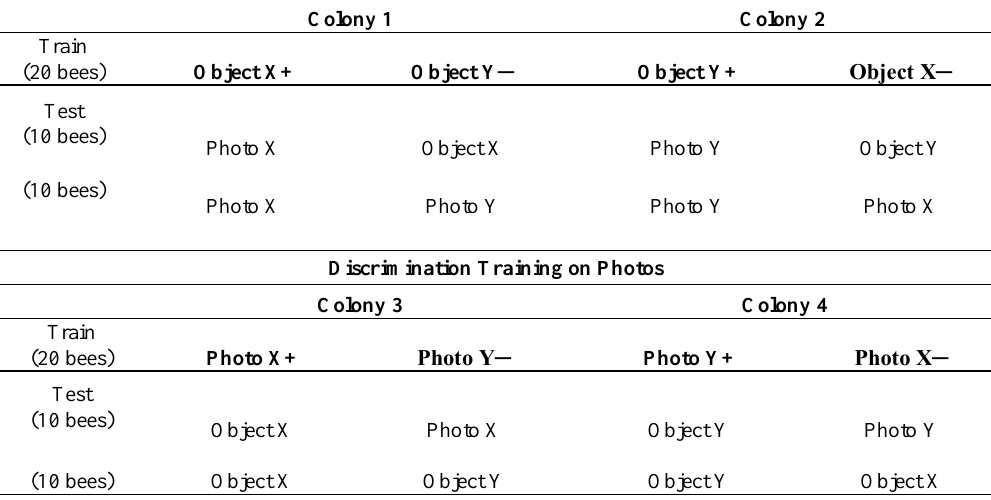
Design for Discrimination Training and Subsequent